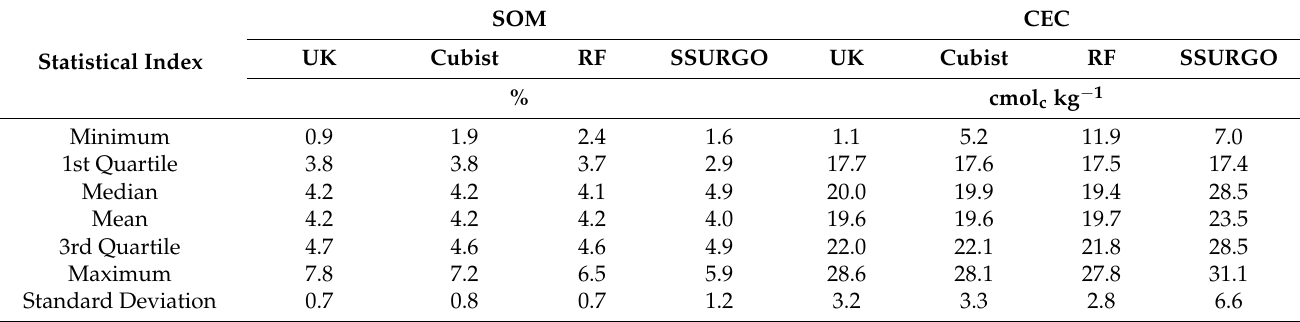
Table 6. Summary statistics of universal kriging (UK), Cubist, random forest (RF), and soil